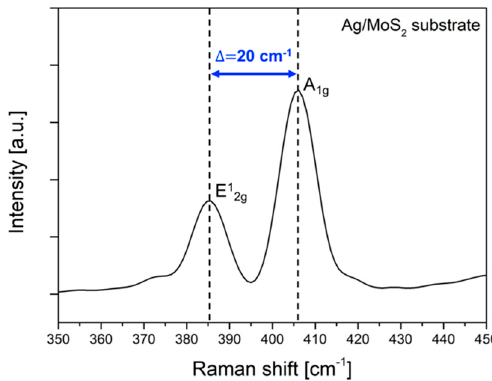
Figure 2. Raman spectra of the surface of Ag/MoS 2 substrate. To confirm the number of MoS 2 layers, wavenumber gap between E 12g and A 1g mode is obtained. The measured Raman peaks are 386 cm − 1 and 406 cm − 1 (i.e., Δ = 20 cm − 1 ), supporting that the fabricated MoS 2 layer on the Ag substrate is a single layer.